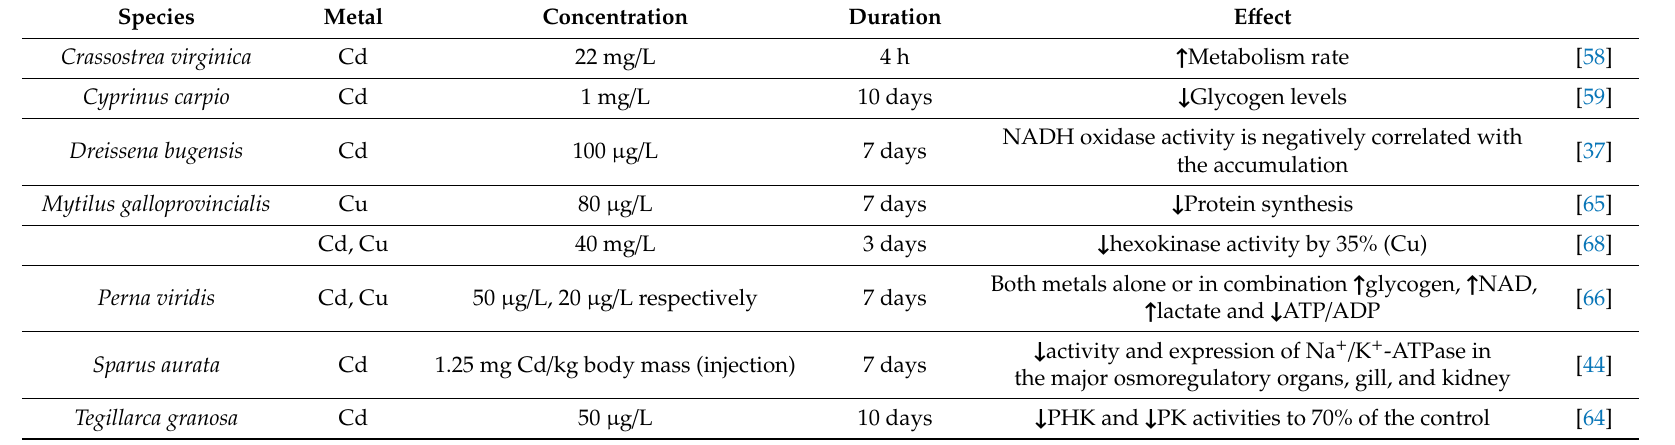
Table 4. Summary of studies describing toxic metal impacts on metabolism reshu ffl